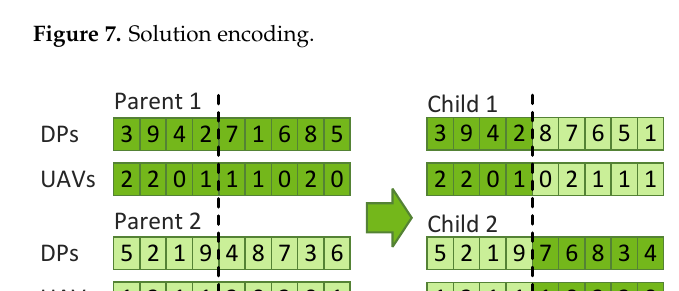
Figure 7. Solution encoding.